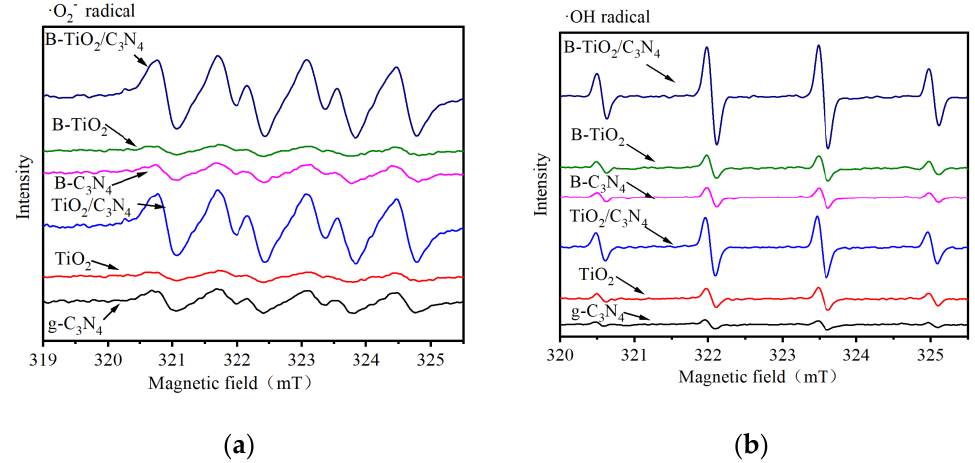
Figure 9. Spectrum of DMPO spin trapping ESR of different materials ( a ) DMPO-O 2 − and ( b ) DMPO- ·OH.